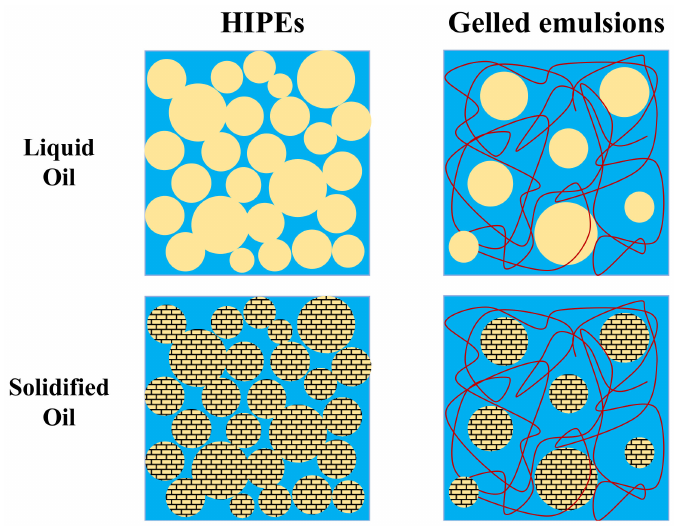
Figure 1. Structural differences between HIPEs and gelled emulsions containing either liquid oil or partially solidified solid